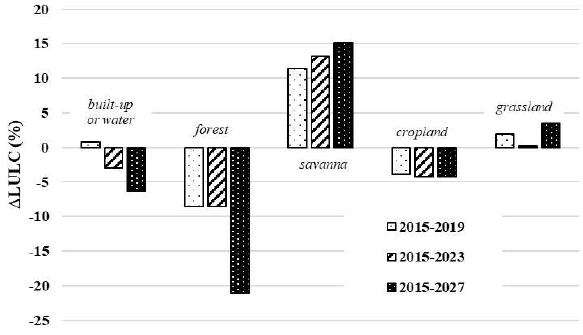
Figure 7 . Percentage of LULC changes from